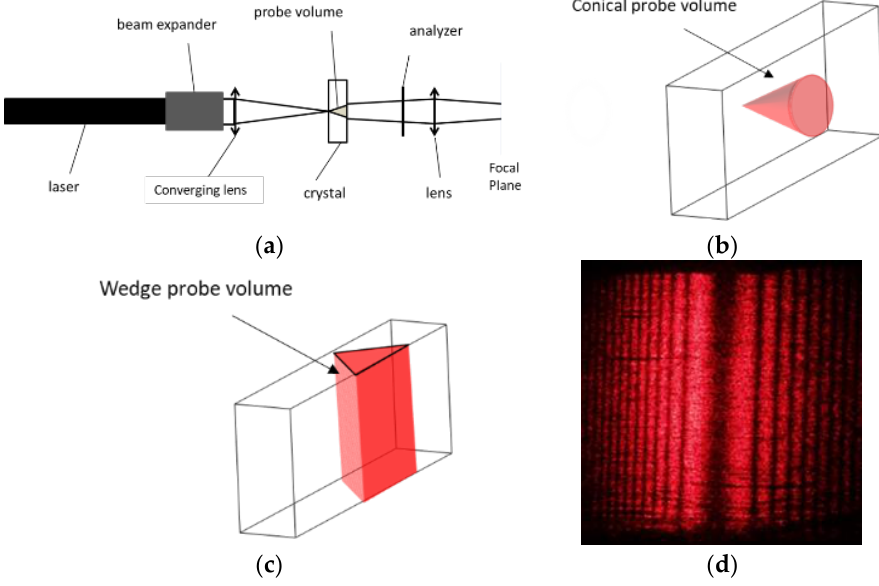
Figure 3. ( a ) The basic scheme of the laser conoscopy/sphenoscopy technique. The main difference is the use of a spherical (conoscopy) or cylindrical (sphenoscopy) lens that generates different probe volumes. ( b ) The conoscopic probe volume for the punctual inspection. ( c ) The wedge-shaped volume generated by sphenoscopy, which allows us to analyze an entire line of the sample. ( d ) The sphenoscopic fringe pattern obtained along the optic axis. The stripes are due to the envelope of the conoscopic fringe orders along the height of the wedge (used with permission from Copyright Clearance Center/AIP Publishing, [33]).